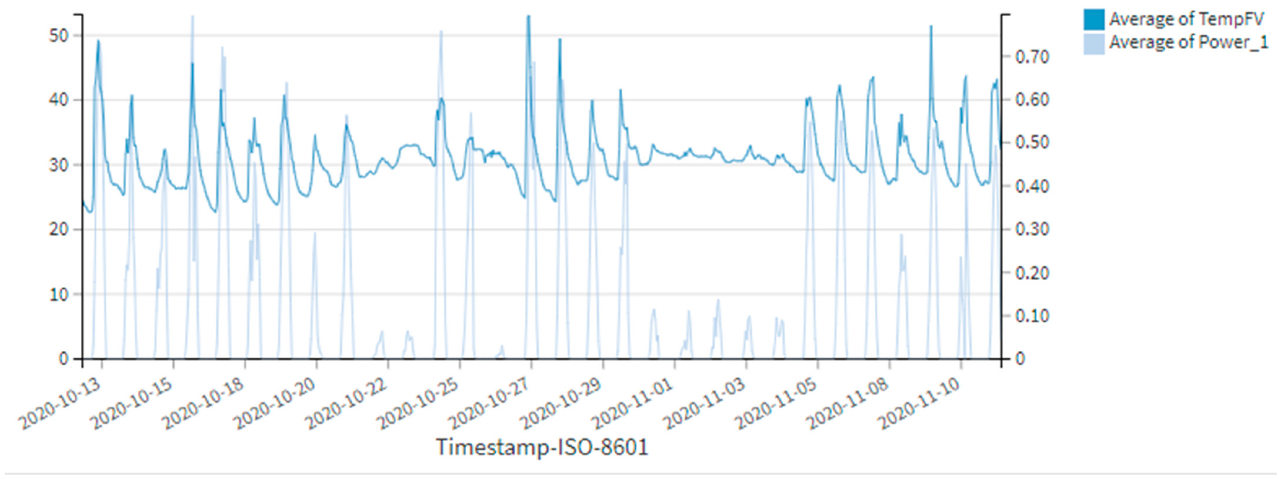
Figure 4. Data samples for the analyzed period.